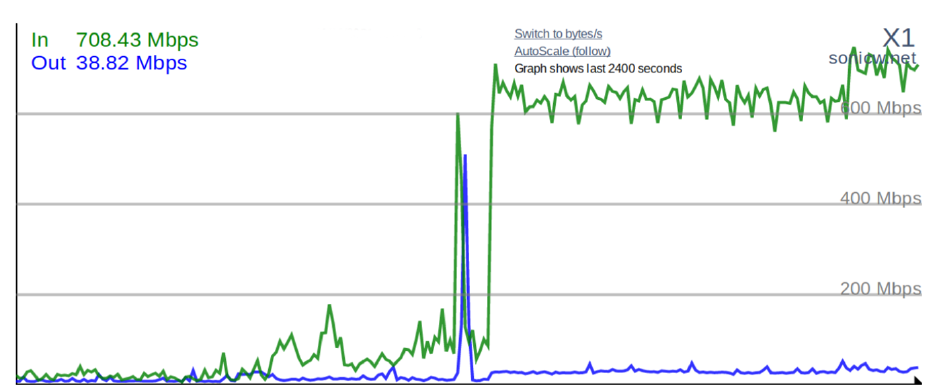
Figure 5. Firewall